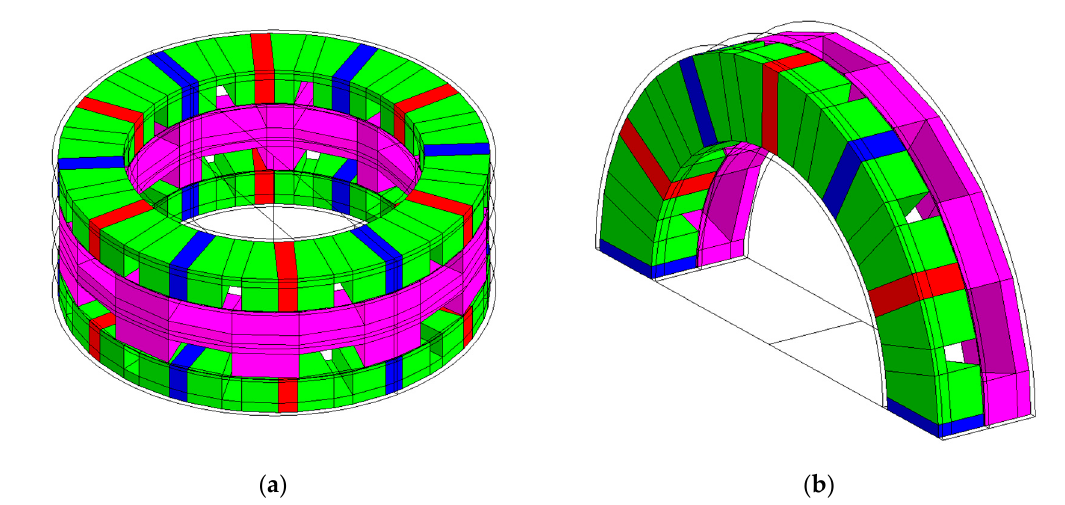
Figure 4. AFSPM geometry with symmetry and periodicity conditions: ( a ) full machine geometry; ( b ) geometry to be modeled after applying anti-symmetry and cyclic boundary conditions.